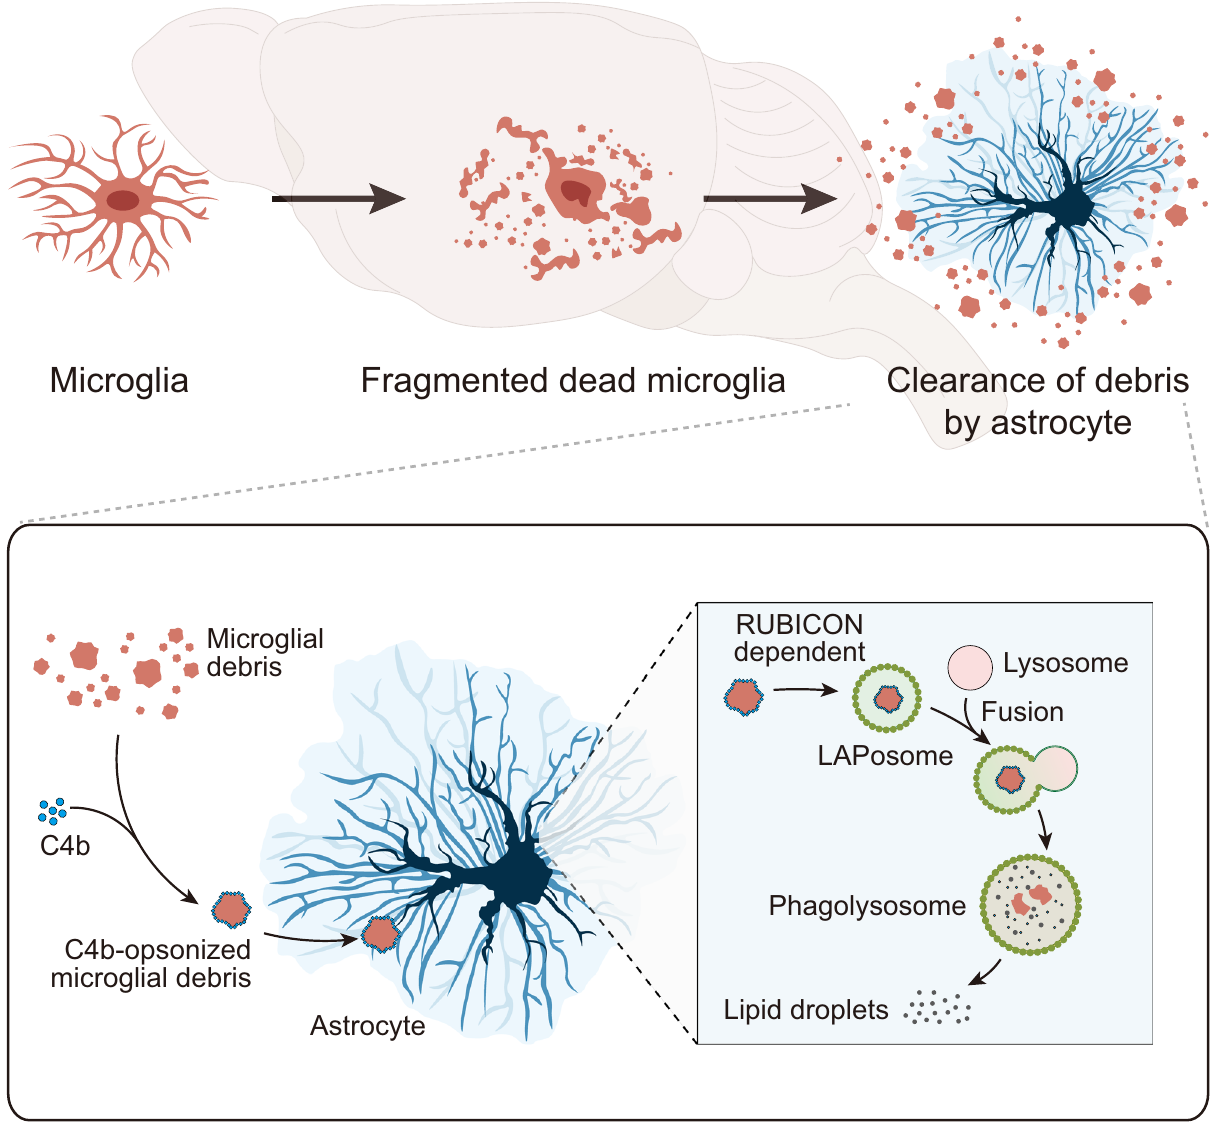
Fig. 10 | Model of microglial debris removal and degradation by astrocytes in the brain. The debris of microglia (professional phagocytes) is primarily engulfed byastrocytes(nonprofessionalphagocytes),whichisfacilitatedbyC4opsonization.